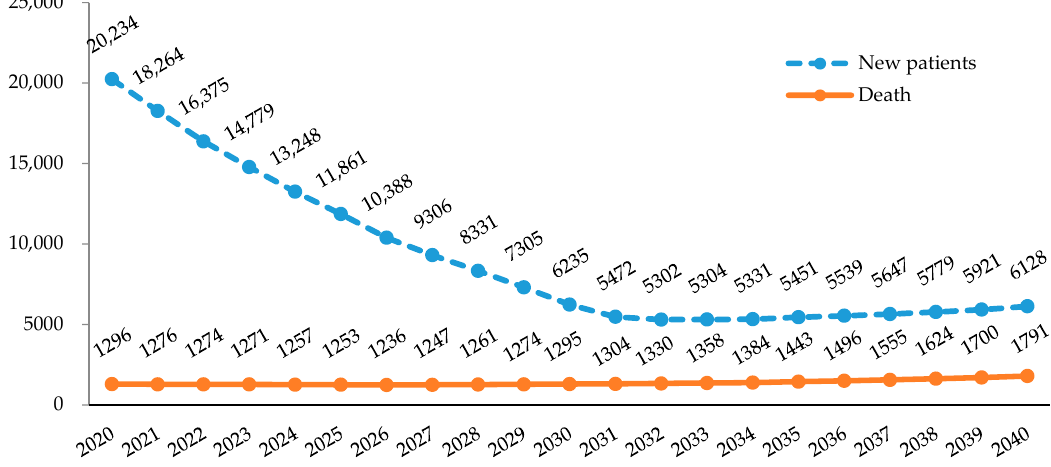
Figure 2. Projected number of new cases of tuberculosis and deaths caused by tuberculosis in Korea,